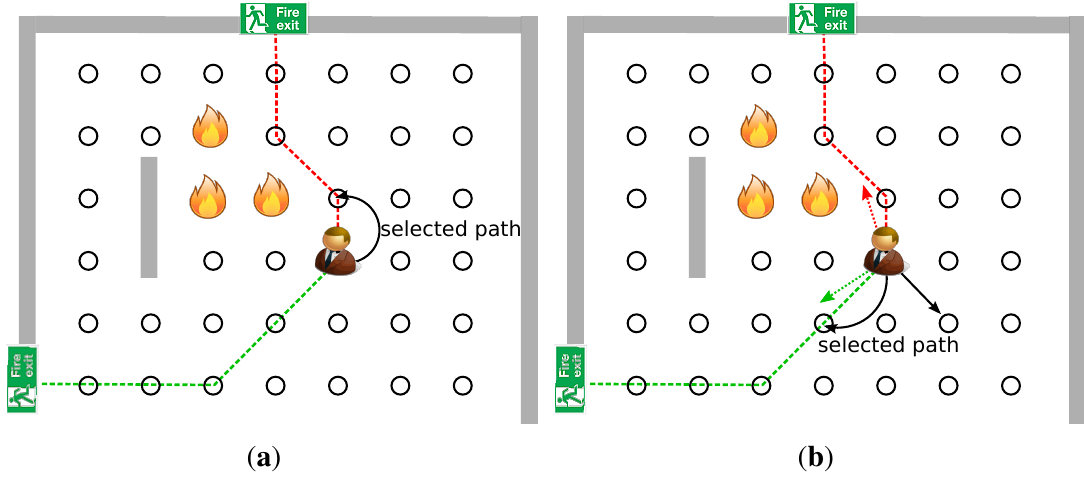
Figure 1. An evacuation example. ( a ) Based on the shortest path the civilian will choose the “red” path; ( b ) By using directions, our algorithm can guide the civilian through the safer “green”